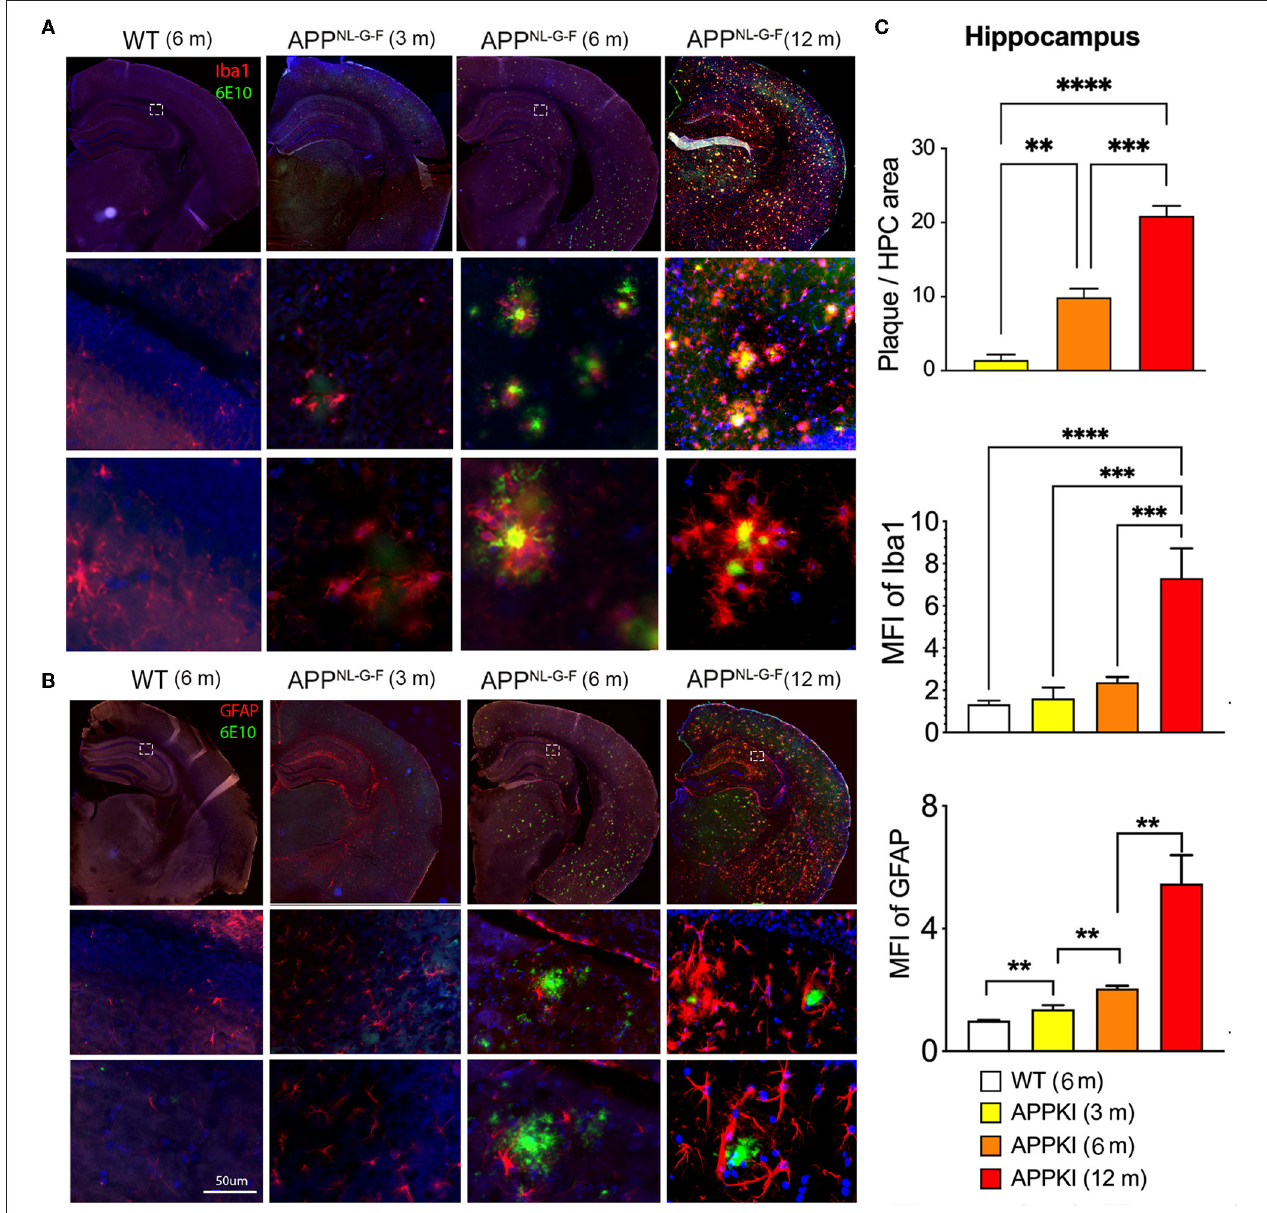
FIGURE 4 | Age-dependent neuroinflammation and amyloidosis in APPKI mice. (A) Iba-1/6E10 and (B) GFAP/6E10 dual staining of APPKI mice brain at 3, 6–8, and 12–14 months. (C) Quantification of plaque load, Iba-stained microgliosis, and GFAP-stained astrocytosis in hippocampal region. n = 3–4 mice per group. A minimum of two sections from each mouse were used for quantitation. Data are presented as mean ± SEM and were analyzed using one-way ANOVA followed by LSD multiple comparison test. Significance was assumed when p < 0.05. ** p < 0.01, *** p < 0.005, **** p <